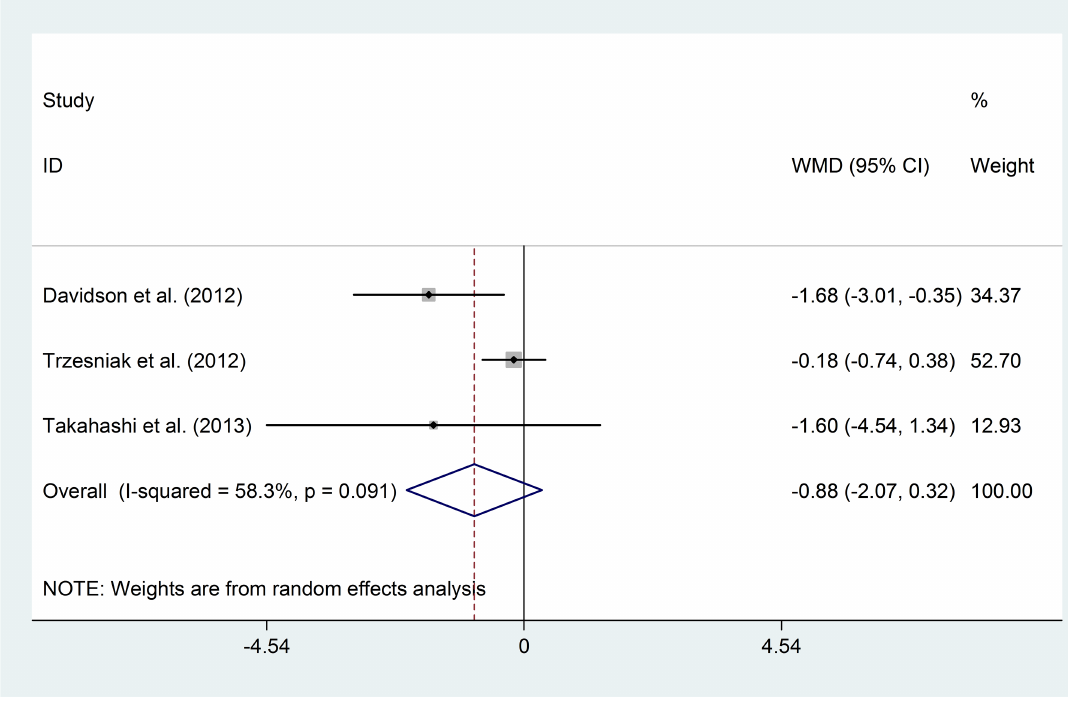
Fig 7. CSP length in the FEP patients and healthy controls.